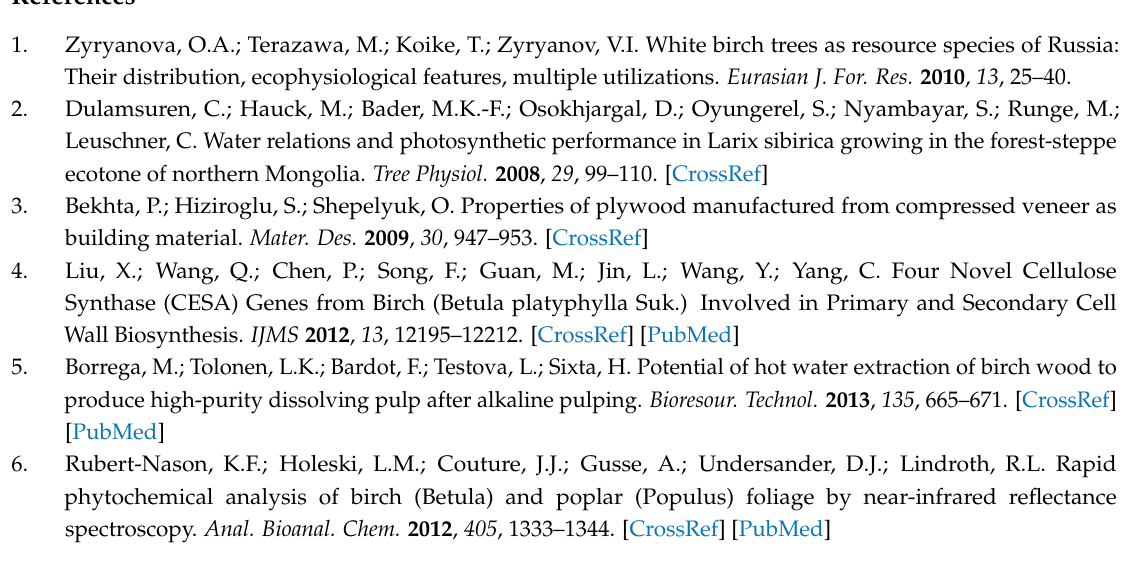
Table S1: The correlation analysis between pigment contents and